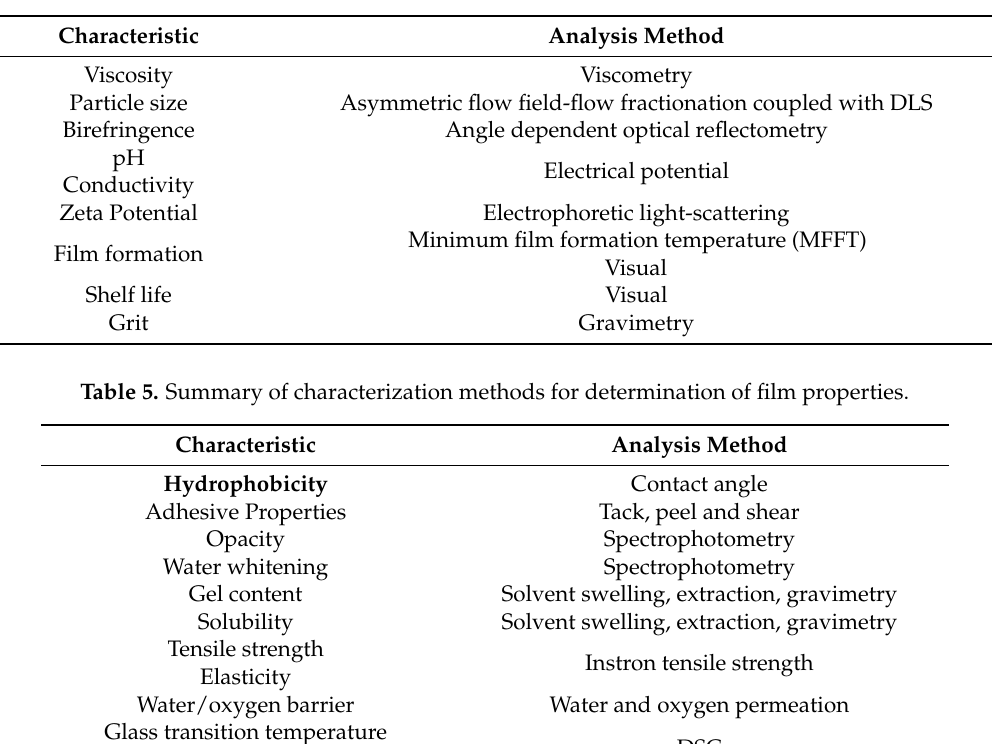
Table 4. Summary of characterization methods for determination of latex properties.